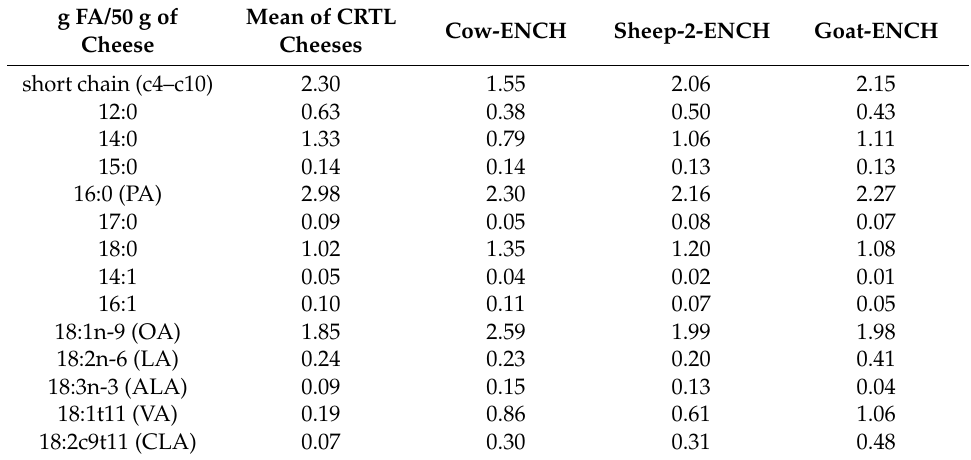
Table 4. FA profiles (g FA/50 g cheese) of the control and of the cow-, sheep-2-, and goat-ENCH